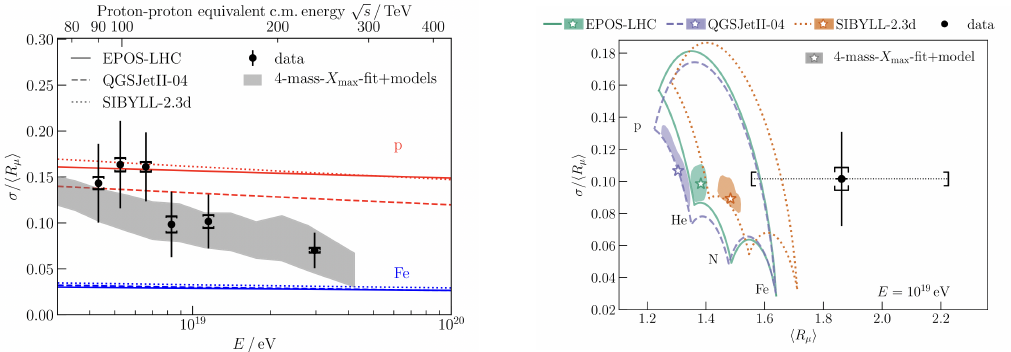
Figure 3: Left: Relative fluctuations in the number of muons as a function of energy. Predictions from hadronic interaction models for proton and iron primaries are also shown. The grey band shows the expected values from mass composition measure- ments. Right: Auger measurement and model predictions for the fluctuations and average muon number for the events in the energy bin corresponding to 10 19 eV. [ 8